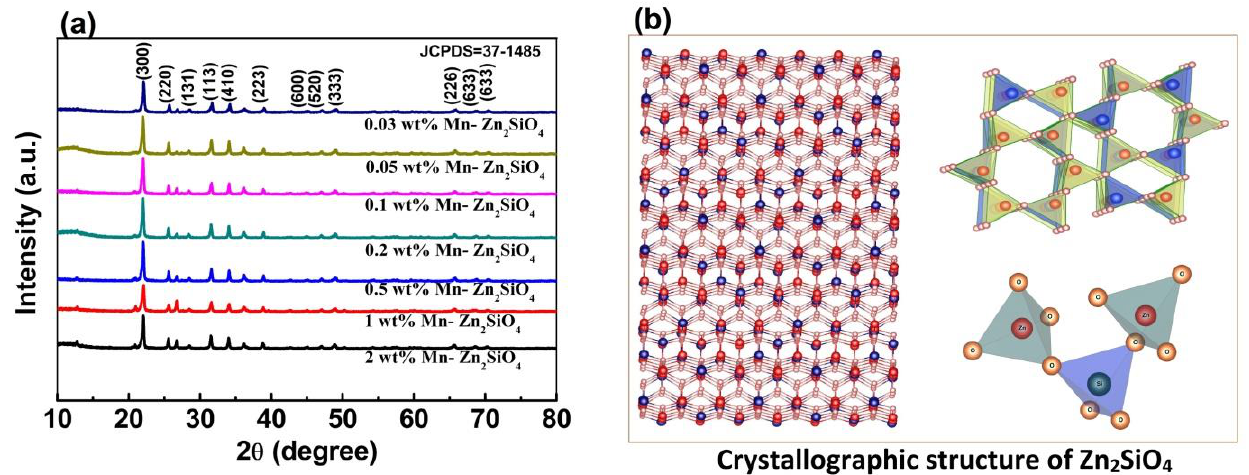
Figure 3. ( a ) XRD patterns of Zn 2 SiO 4 with different Mn doping concentrations ranging from 0.03 wt% to 2 wt%. ( b ) Unit cell of Zn 2 SiO 4 and in case of Mn doping, Mn goes to Zn site (Zn 2+ : Red; Si 4+ : Blue; O 2- :Orange).